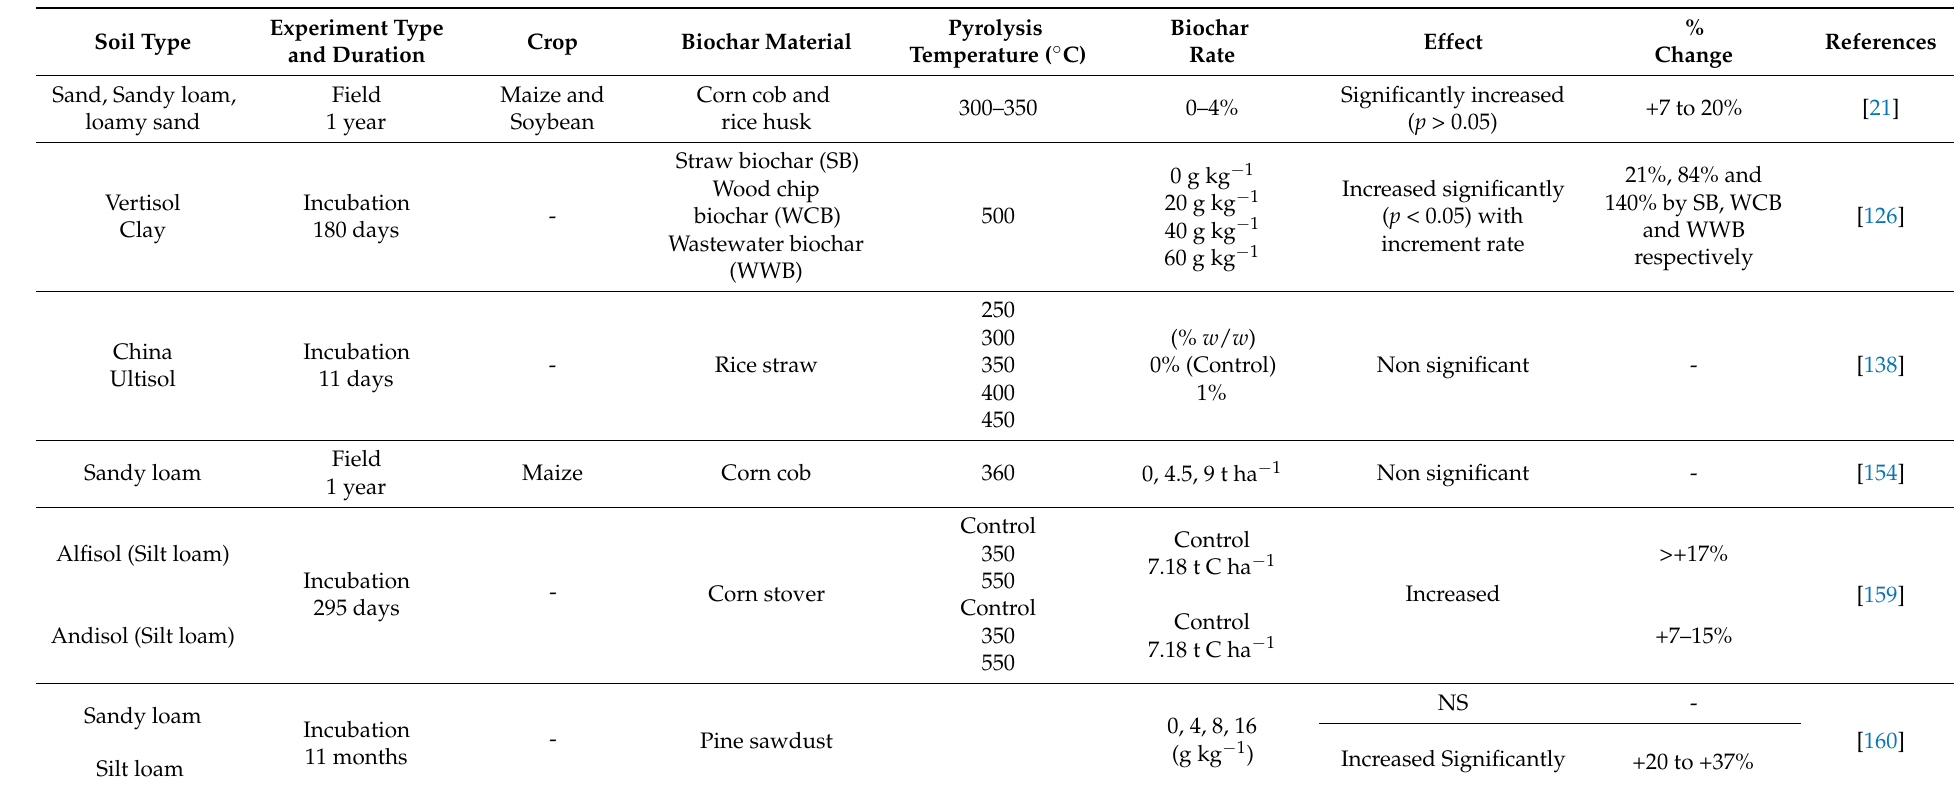
Table 7. Soil aggregate stability of different types of soil influenced by biochar